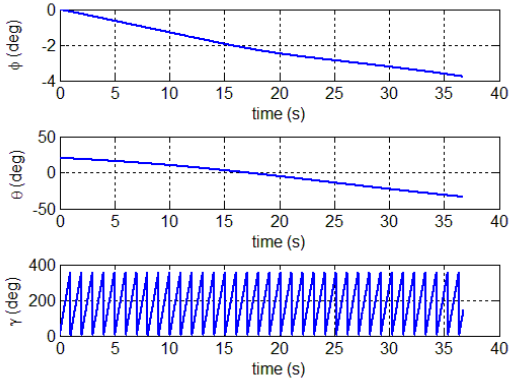
Figure 16. Trajectory of a spinning projectile. Figure 17. The full attitude of projectile. Figure 17. The full attitude of projectile.